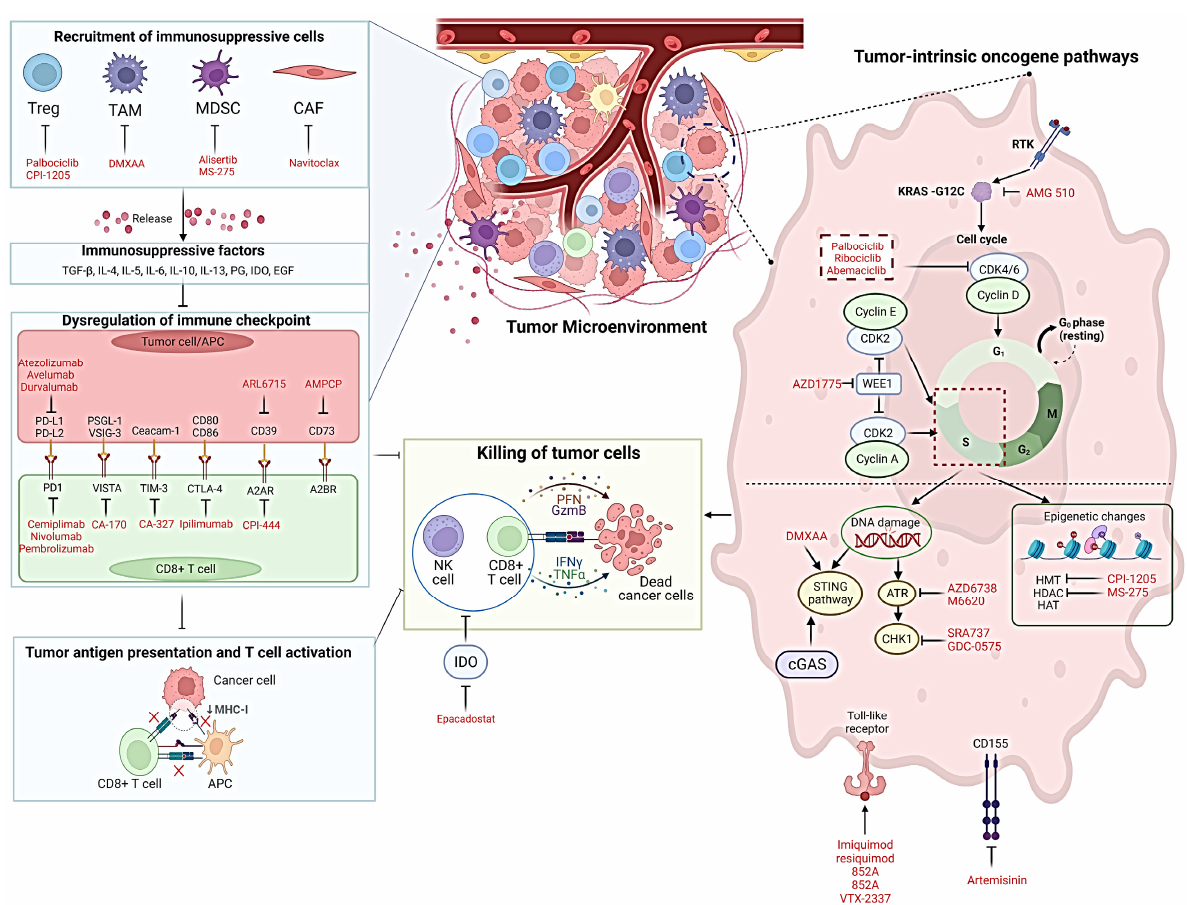
Figure 1. Tackling immunosuppression imposed by hostile TME using Small Molecule Inhibitors (SMIs) to improve ICB. The TME recruits immunosuppressive cells, for example, Treg, TAM, MDSC, and CAF. Those inhibitory cells release immunosuppressive factors (e.g., TGF- β , IL-4, IL-5, IL-6, IL-10, IL-13, PG, IDO, and EGF), and further cause the dysregulation of immune checkpoints, inhibition of tumor antigen presentation, and suppression of T cell activation. Among the inhibitors for immune checkpoints, atezolizumab, avelumab, and durvalumab target PD-L1, whereas semiplimab, nivolumab, and pembrolizumab target PD-1. There are also inhibitors for VISTA (CA-170), TIM-3 (CA-327), CTLA-4 (Ipilimumab), A2AR (CPI-444), CD39 (ARL6715), and CD73 (AMPCP). Such immunosuppressive environment suppresses the killing of tumor cells by CD8 + T cells and NK cells, enabling immune evasion. The inhibitors currently in use for inhibiting the shown intrinsic oncogenic signals (highlighted in red) have been shown to modulate immune response by overcoming immunosuppression. Therefore, these SMIs can be a powerful to enhance the clinical efficacy of ICB. Abbreviations: TME, tumor microenvironment; SMIs, small molecule inhibitors; Treg, regulatory T cells; TAM, tumor associated macrophages; MDSC, myeloid-derived suppressor cells; CAF, carcinoma associated fibroblasts; APC, antigen-presenting cell; HMT, methyltransferases; HDAC,